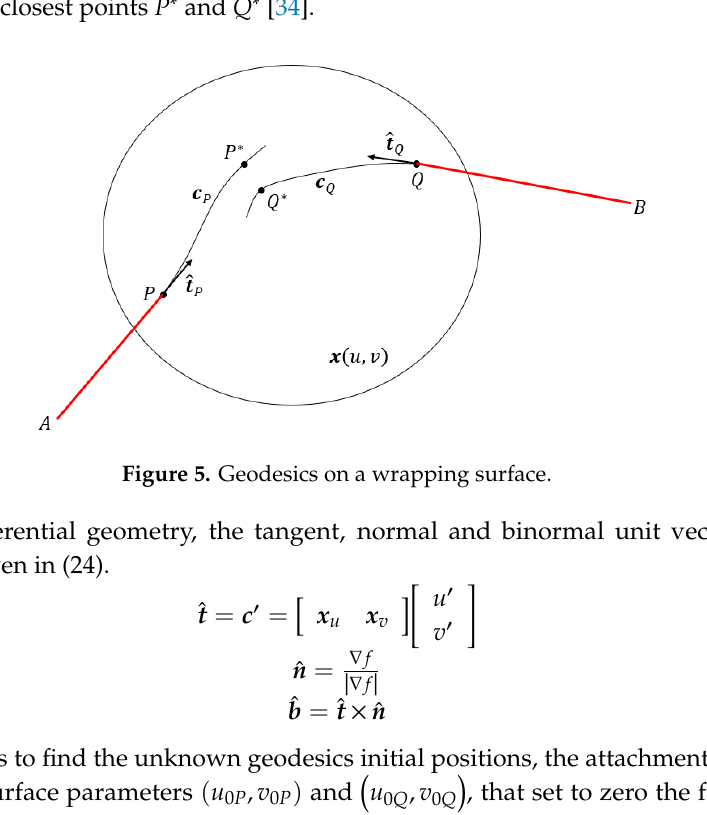
With reference to Figure 5, in correspondence with each time instant, the model detects the contact between the straight-line muscles AB . and the associated surfaces x ( u , v ) ; then it calculates the geodesics starting from the two intersections P and Q on the surface, c P and c Q , varying the attachment points location until the original muscle AB is split in two straight-line muscle units AP and QB tangent to the surface while the related geodesics are collinear to each other in correspondence ∗ ∗ with the geodesics’ closest points P and Q [34].